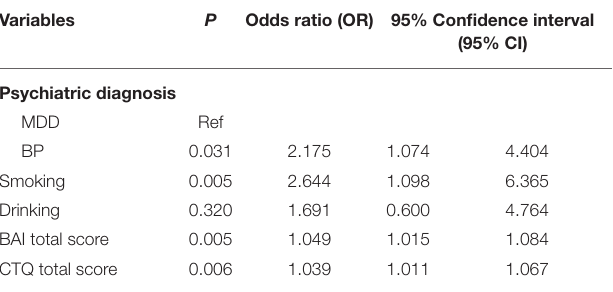
TABLE 2 | Multiple logistic regression model assessing variables associated with SAs among adolescents and young adults with first depressive episode.